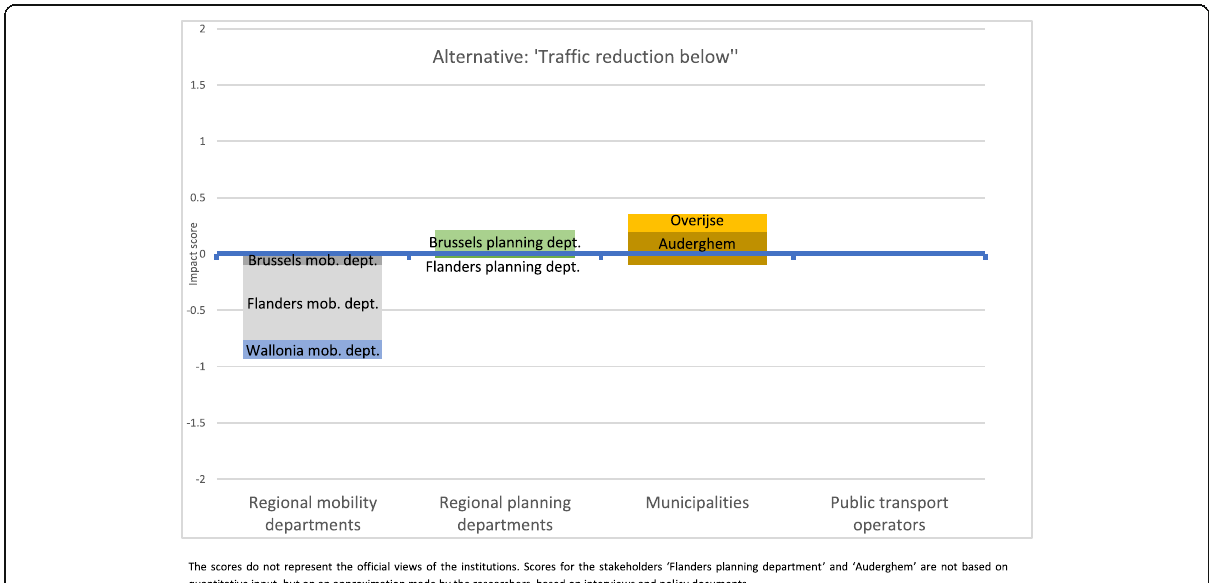
Fig. 9 Impact scores of the alternative ‘ Traffic reduction below ’ . (Maximum possible positive or negative impact for one stakeholder = 1, resp.